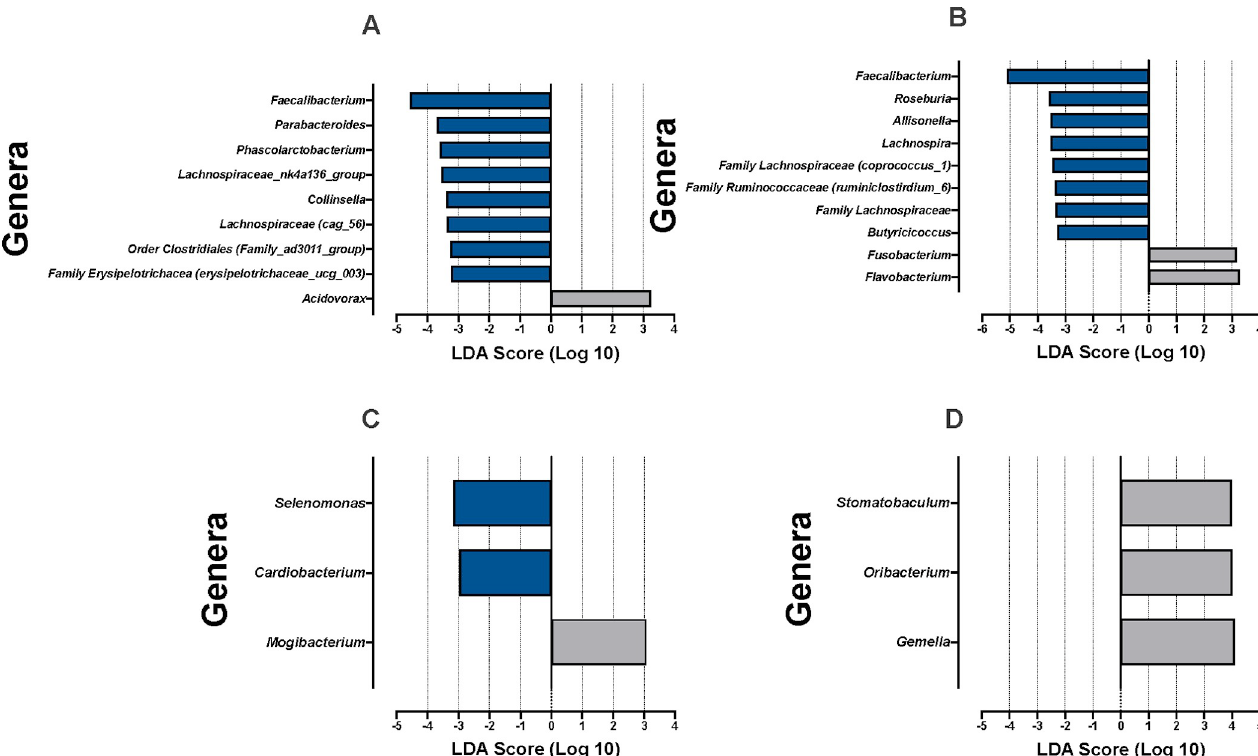
Fig 9. LEfSe of stool and salivary IgA-Biomes by Th17:Treg ratio-derived inflammatory phenotypes. LEfSe identified genera (or next taxonomic designation available) associated with the Th17:Treg ratios in ( A ) stool SIgA + , ( B ) stool SIgA - , ( C ) saliva SIgA + , or ( D ) saliva SIgA - compartments. Analyses were conducted using parameters α < 0.05 and linear discriminant analysis (LDA) threshold � 2.0.